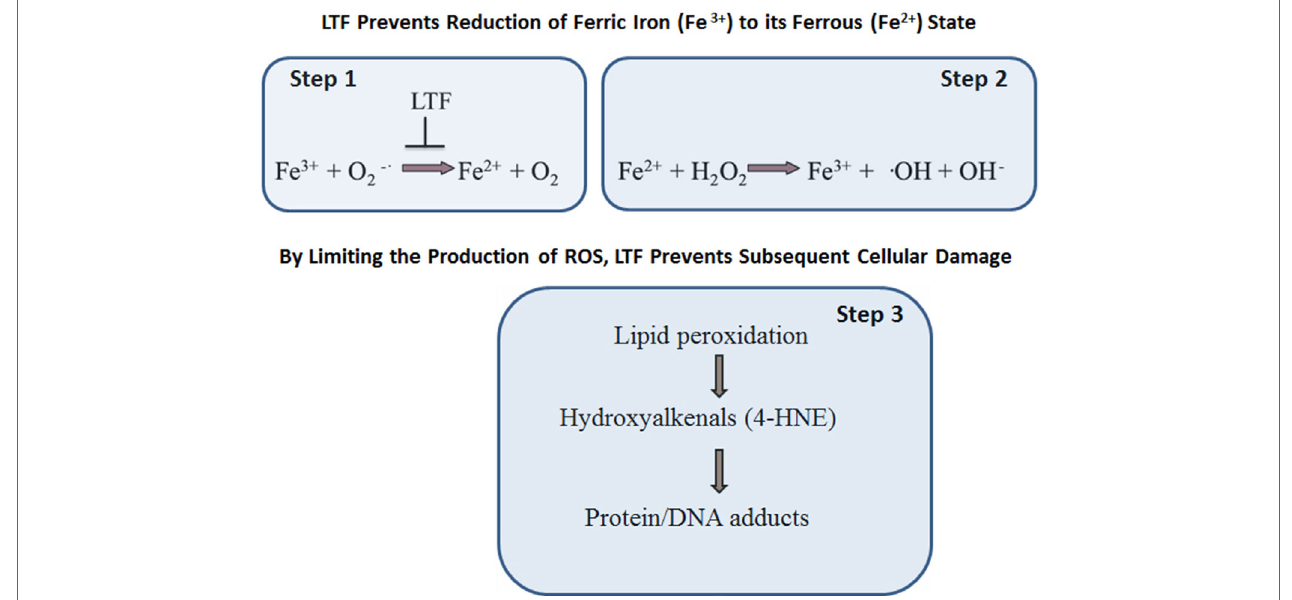
FigURe 3 | Lactoferrin (LTF) protects against oxidative stress-induced cellular damage. LTF inhibits free ferric (Fe 3 + ) ions reactivity with superoxide molecules, thus limiting formation of ferrous (Fe 2 + ) salt and ground state oxygen (step 1). In turn, there is reduced reactivity of ferrous (Fe 2 + ) ion with hydrogen peroxide to form ferric (Fe 3 + ) salt, a hydroxyl radical, and an alcohol (step 2). The end result is that LTF protects against oxidative stress, in particular by limiting the production of hydroxyl radical and lipid peroxidation (step